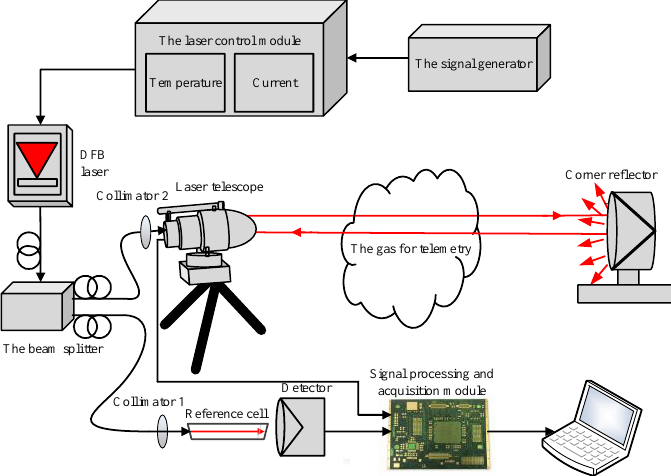
Figure 1. System construction.